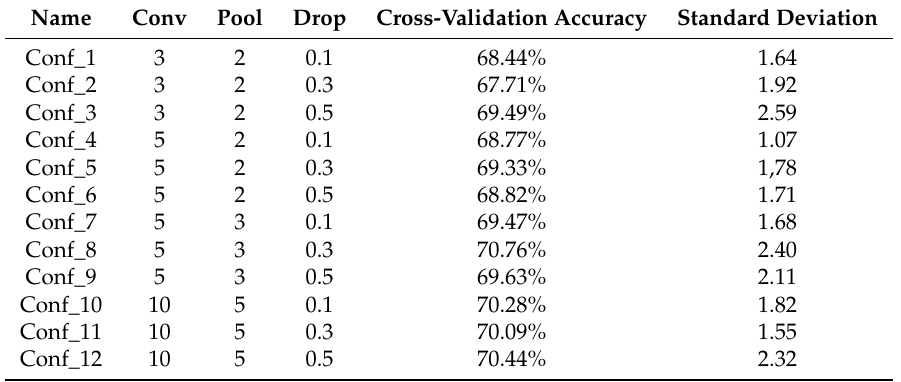
Table 2. Cross-validation accuracy over 10 repetitions for each network configuration